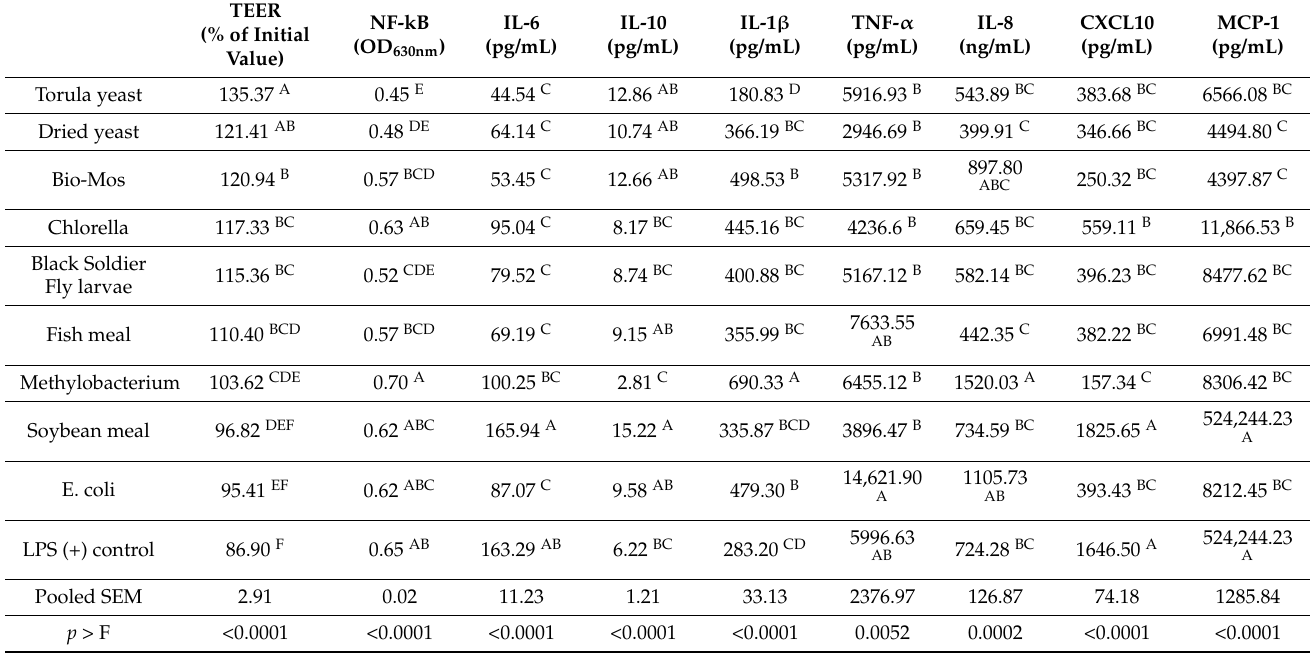
Table 3. Effects of various protein sources on transepithelial electrical resistance (TEER) and IL-6, IL-10, IL-1 β , TNF- α , IL-8, CXCL10, MCP-1, and NF- κ B production in a leaky gut cell culture model (Caco-2/THP-1) after LPS stimulation. LPS positive control was stimulated with LPS, but no protein was administered. p values of one-way ANOVA described as p > F; values within a column that do not share a letter are significantly different ( p < 0.05). SEM is the standard error of the mean.